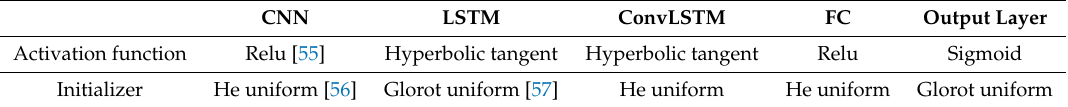
Table 1. Activation function and initializer of each neural